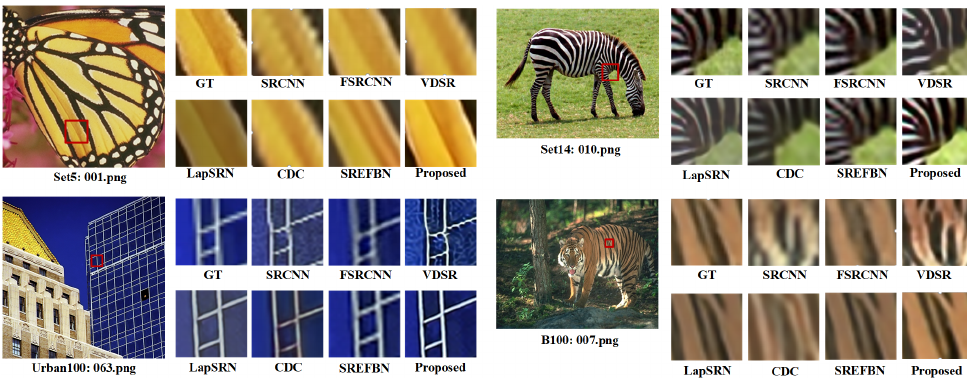
Figure 6. Visual comparisons with different methods for 3 × super-resolution on the Set5, Set14, B100, and Urban100